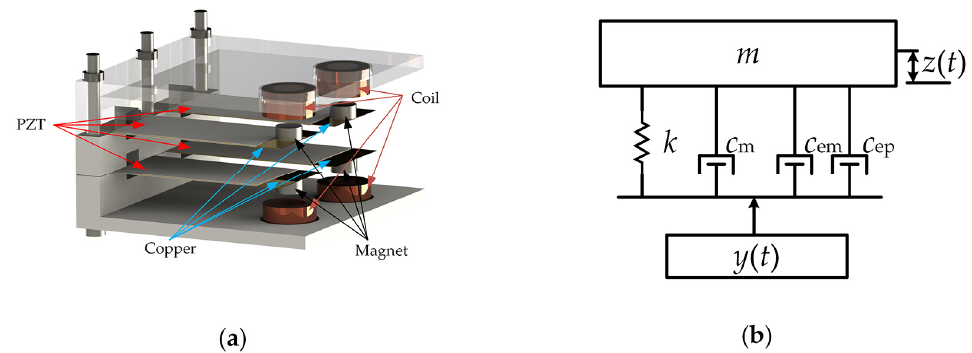
Figure 1. ( a ) Schematic view of the hybrid energy harvester based on PEG and EMG; ( b ) lumped model of the hybrid energy harvester.